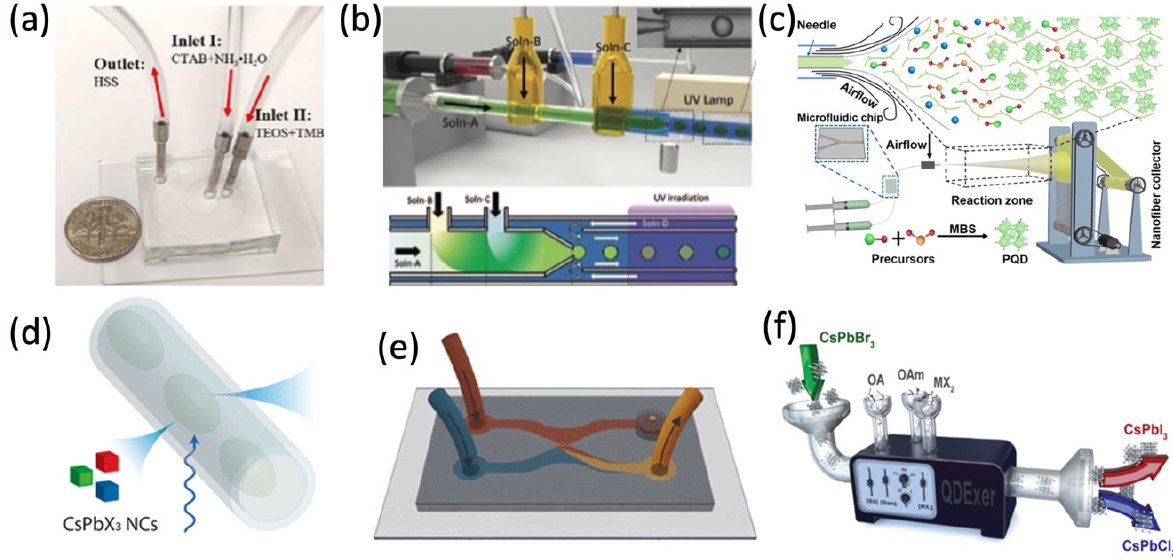
Figure 1. Various microfluidic syntheses of perovskite nanostructures and composite. ( a ) Microfluidic setup with a U.S. dime coin for comparison. Adapted with permission from Ref. [25]. Copyright 2019 Elsevier B.V. ( b ) Synthesis of perovskite composite microparticles. Adapted with permission from Ref. [26]. Copyright 2021 Wiley-VCH GmbH. ( c ) Formation of MAPbBr 3 PQDs in nanofiber.